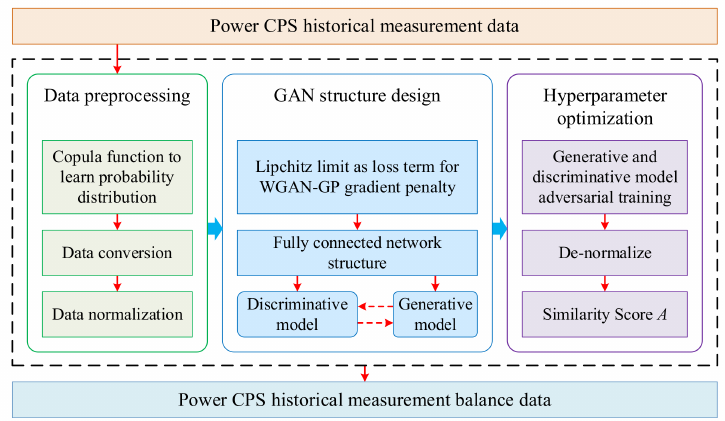
Figure 3. Balancing process of historical measurement